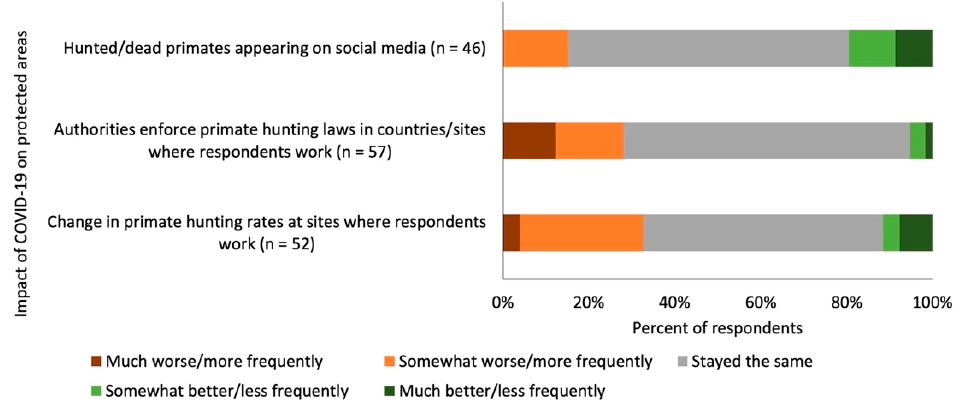
Figure 3. Opinions given by respondents on the how the COVID-19 pandemic had affected different aspects of primate hunting in sites and countries where they worked.